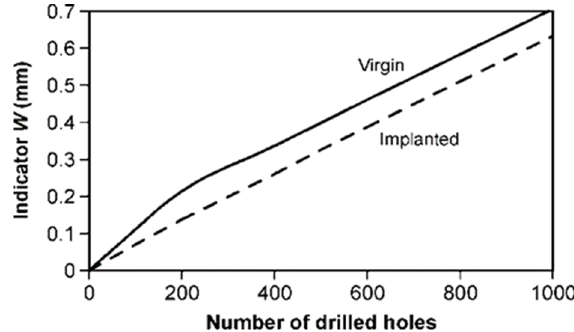
Figure 10. Modeled wear curves of virgin and implanted drills.